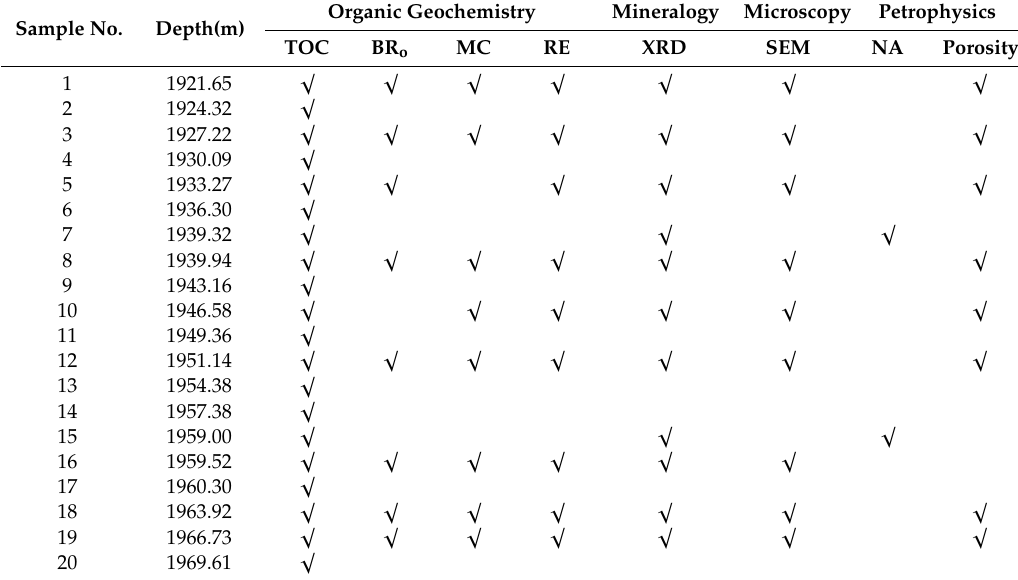
Table 1. Experiments and measurements conducted on samples.